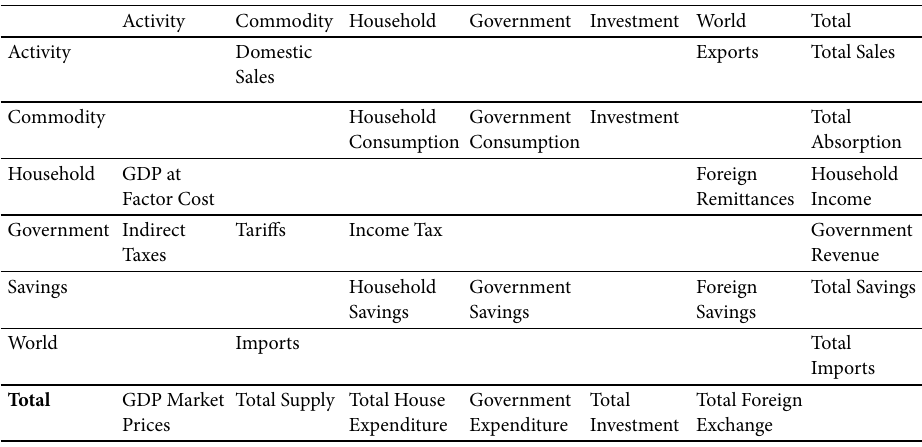
table 1. Theoretical social accounting matrix for Croatian economy